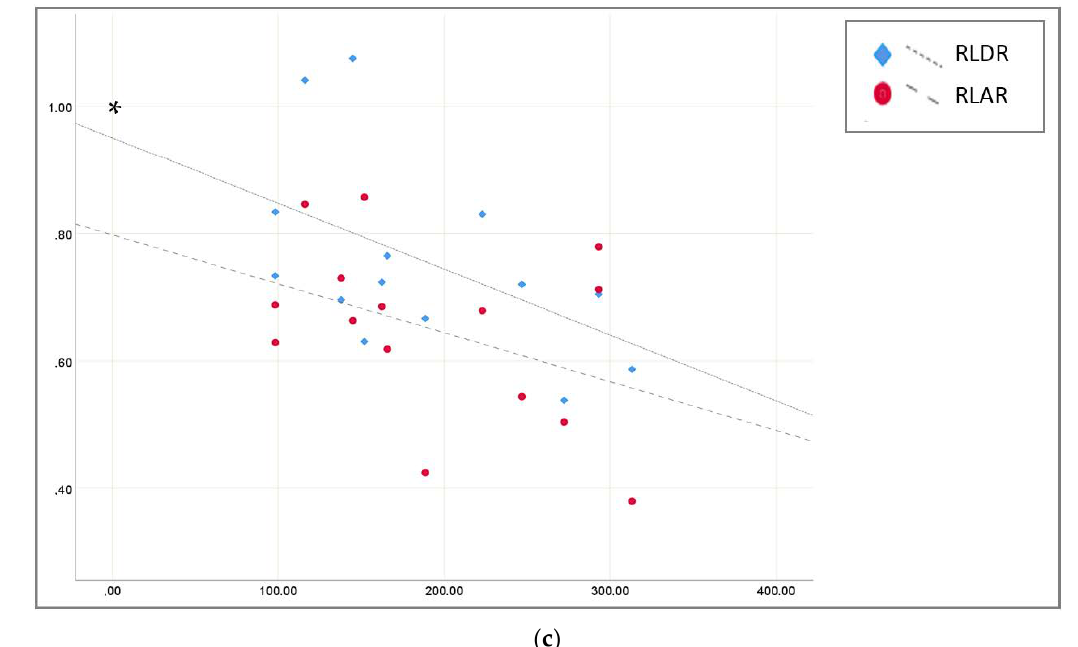
Figure 2. ( a ): Linear regression of RV/LV ratio (RLAR = red; RLDR = blue) and pO 2 /F i O 2 ratio; All measurements (RLDR: r 2 = 0.000, RLAR: r 2 = 0.02); ( b ): Linear regression of RV/LV ratio (RLAR = red; RLDR = blue) and pO 2 /F i O 2 ratio EE